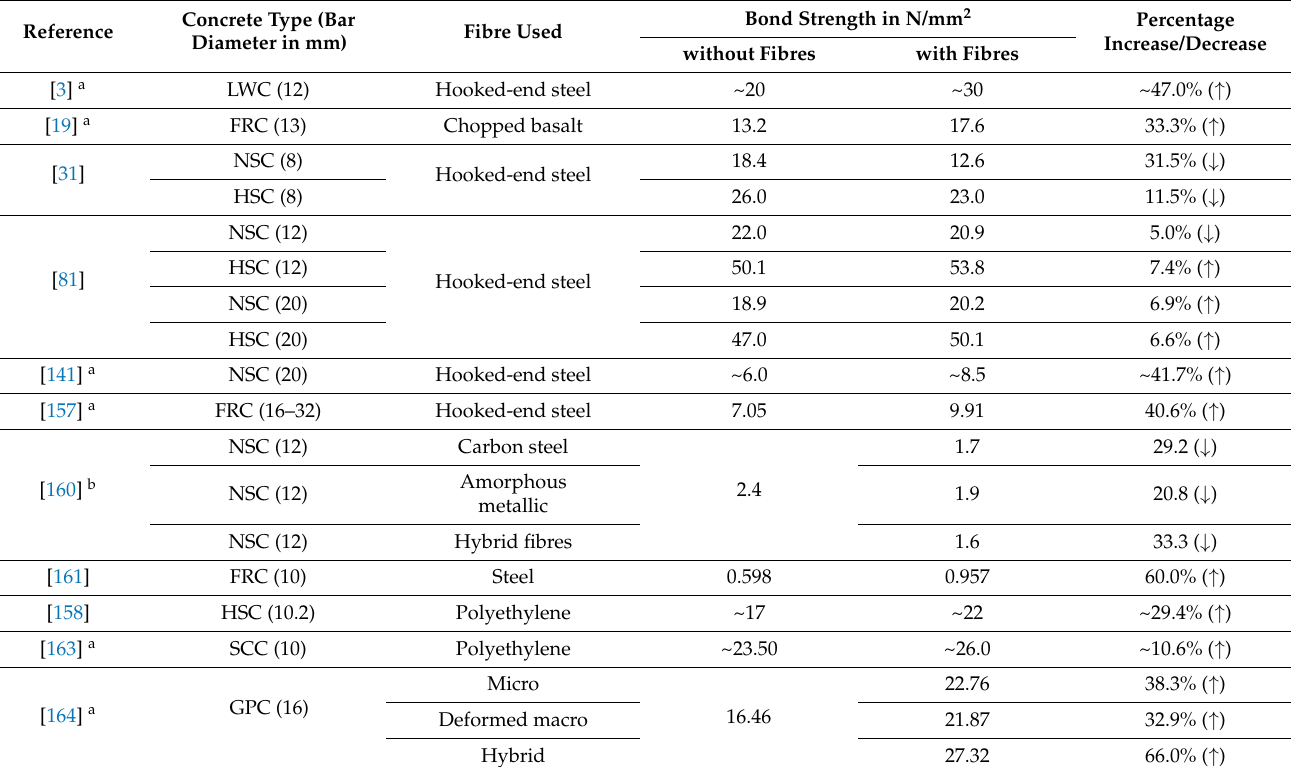
Table 8. Comparison of bond strength results with various fibers in